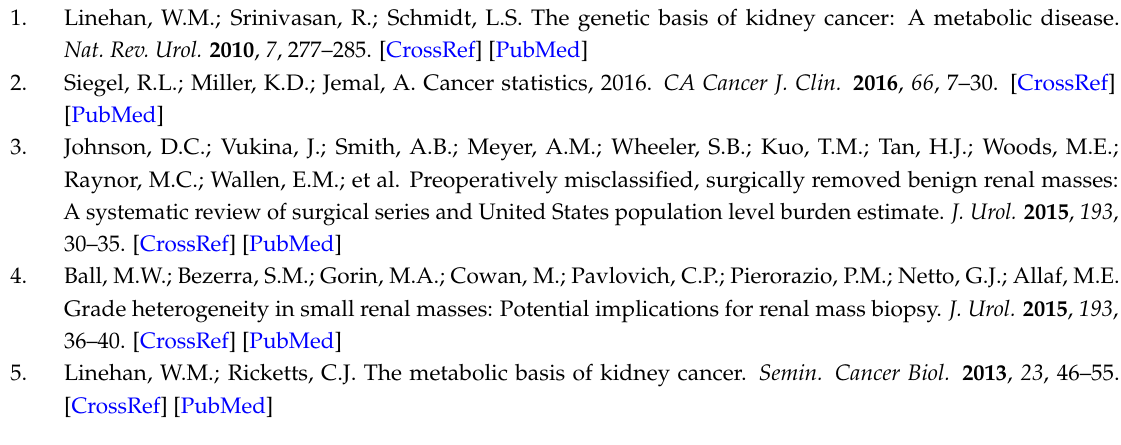
Figure S3. ROC curves depicting the predictive ability of the constructed models in each group comparison in serum and urine. (A) ROC curves illustrating the performance of the GCMS models in distinguishing between benign and stage 3 disease. (B) ROC curve illustrating the performance of the NMR models in distinguishing between benign and stage 3 disease. (C) ROC curve for the NMR models distinguishing between benign and stage 1 disease. AUROC–area under the ROC curve; TPF–true positive fraction (Sensitivity); FPF–false positive fraction (1–Specificity); Figure S4. OPLS-DA regression coefficient plot of NMR analyzed serum and urine. Positive coefficient values (upper portion of the plot) indicate increased serum metabolite concentrations in (A) stage 1 versus benign, (B) stage 3 versus benign, (C) Fuhrman high versus Fuhrman low; urine metabolite concentrations in (D) stage 1 versus benign, (E) stage 3 versus stage 1 (F) Fuhrman high versus Fuhrman low, while negative values (the lower part of diagram) show a decrease in metabolite concentrations; Figure S5. OPLS-DA regression coefficient plot of GCMS analyzed serum and urine. Positive coefficient values (upper portion of the plot) indicate increased serum metabolite concentrations in (A) stage 3 versus benign, (B) stage 3 versus stage 1, (C) Fuhrman high versus Fuhrman low; urine metabolite concentrations in (D) stage 3 versus benign, (E) Fuhrman high versus benign, while negative values (the lower part of diagram) show a decrease in metabolite